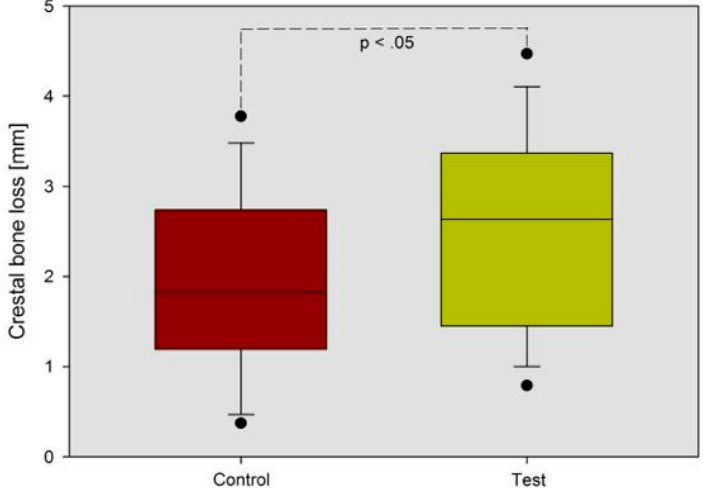
Figure 7. Box plot graphic representation of MBL of both groups after 4 years follow-up, where a statistically significant difference is shown p < 0.05 between the test and control groups (P = 0.02).